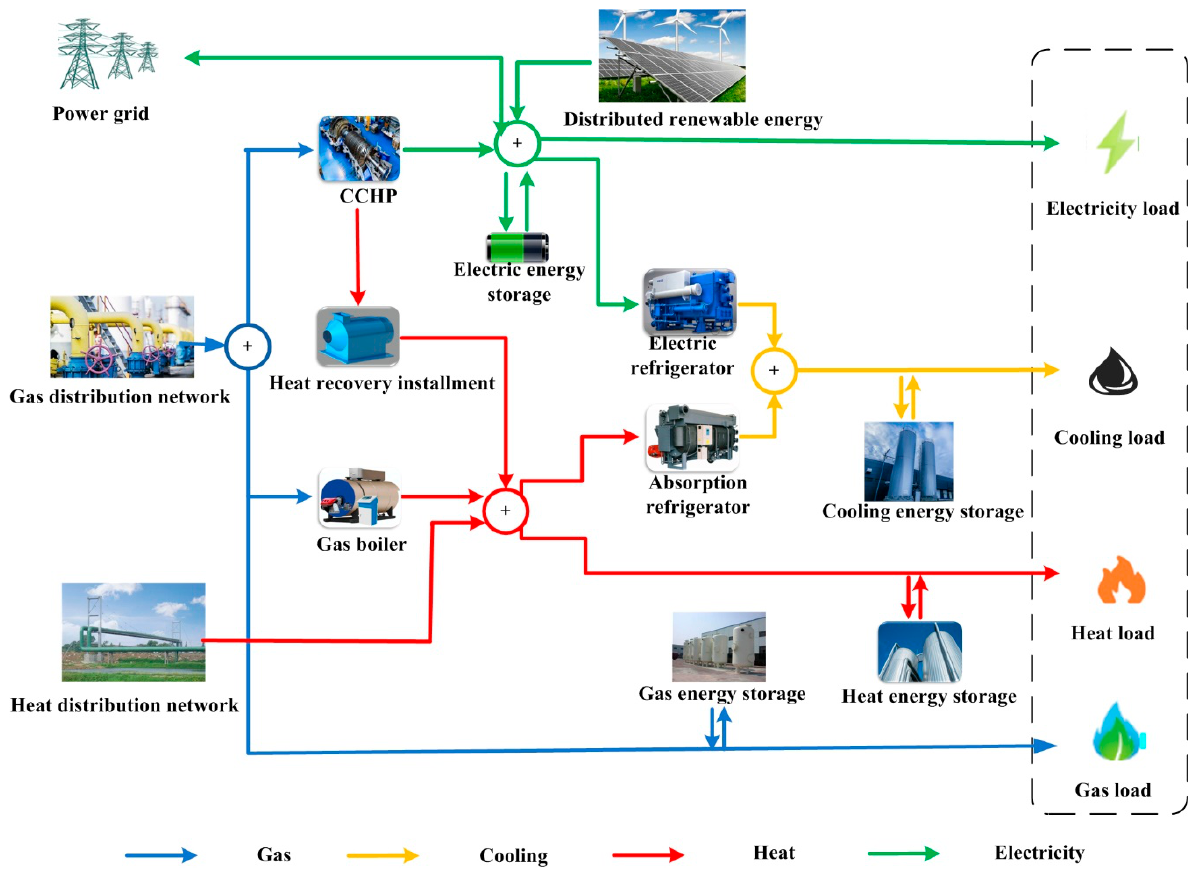
Figure 1. The basic energy flow in the IES.